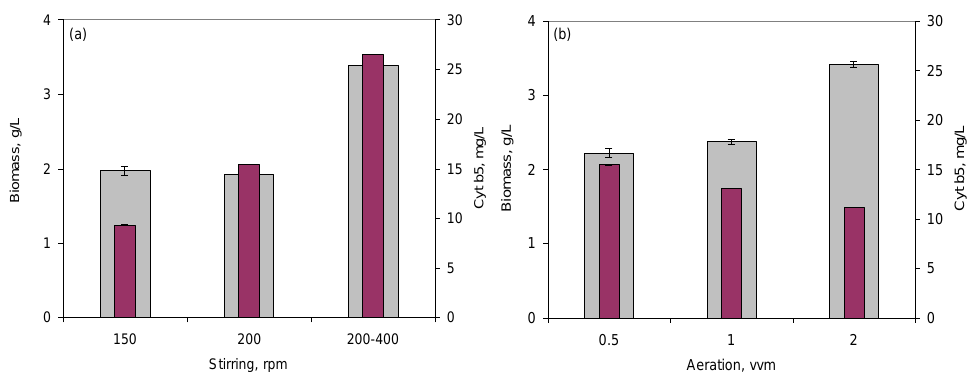
Figure 3. ( a ) Influence of stirring speed on biomass and cytochrome b5 production in the BE bioreactor. The aeration was set at 0.5 vvm, and dissolved oxygen was set at 2%, controlled by “cascade” mode, with stirring kept between 200–400 rpm. ( b ) Influence of air flow rate on biomass and cytochrome b5 production in the BI bioreactor. The dissolved oxygen was set at 2%, controlled by “cascade” mode, with stirring kept between 200–400 rpm.